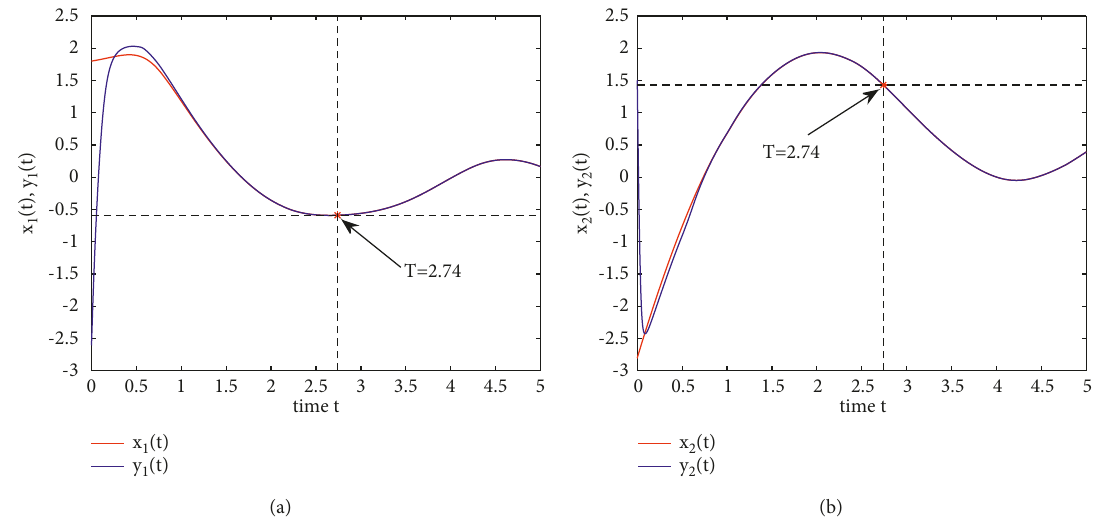
( t ) and e ( t ) for drive-response system without controller. 1 2